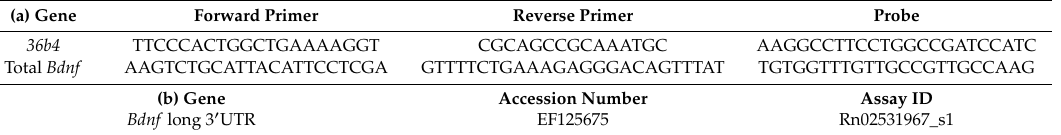
Table 1. sequence of forward and reverse primers and probes used in the real-time polymerase chain reaction analyses and purchased from Eurofins MWG-Operon (Germany) ( a ) and from Life technologies, which does not disclose the sequences ( b